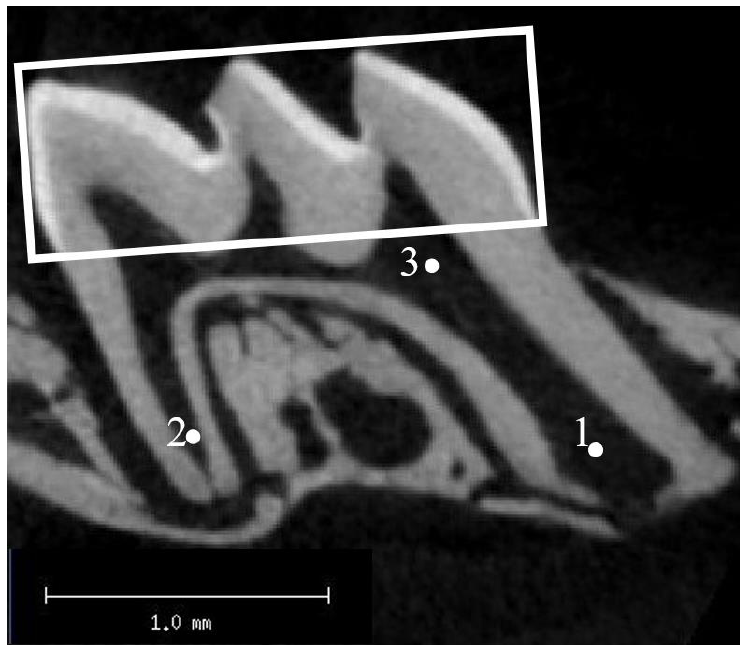
Figure 2. Standardized µCT analysis. µCT analysis included standardized alignment and selection of total crown cubic volume. µCT scans were aligned using three points in the first molar: 1—the mesial apical constriction, 2—the distal apical constriction, 3—coronal part of the mesial canal. Total crown volume from the mesial cemento-enamel junction was marked (white rectangle) over the slice in which the coronal pulp, radicular pulp of both canals, and both apical foramens are presented. Total crown cubic volume (mm 3 ) was determined by the marked rectangle over all slices in which crown enamel was observed.